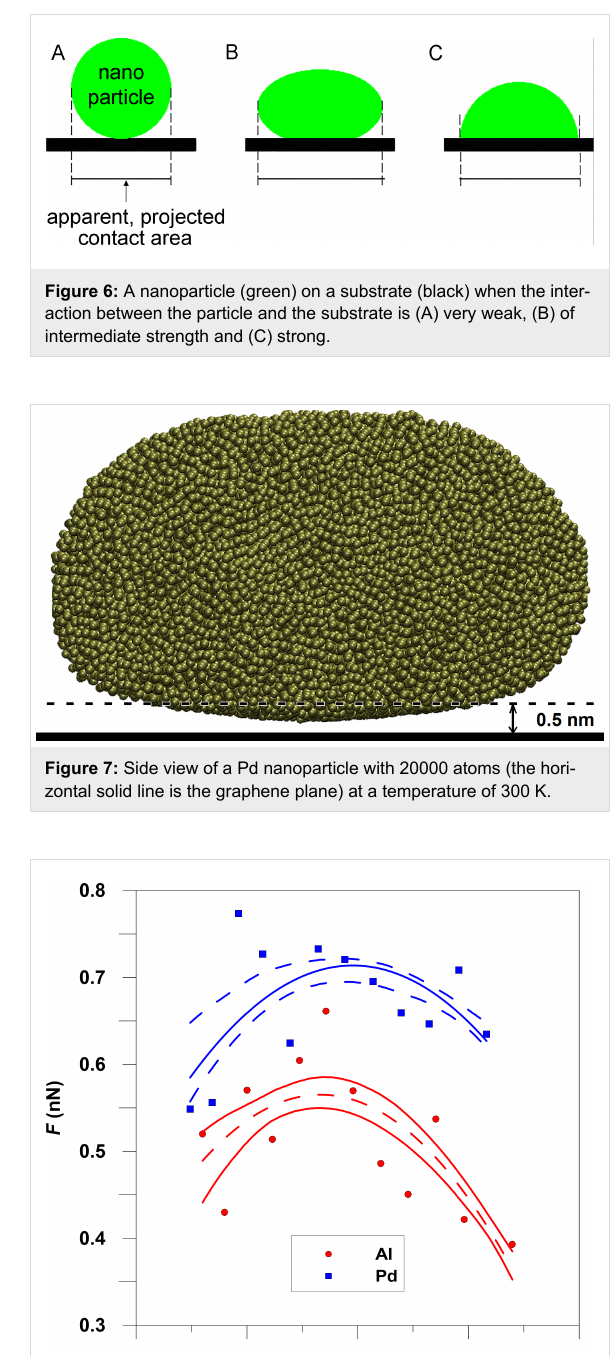
Figure 5: Shear stress as a function of the contact area with confi- dence intervals of the approximation at a temperature 300 K.